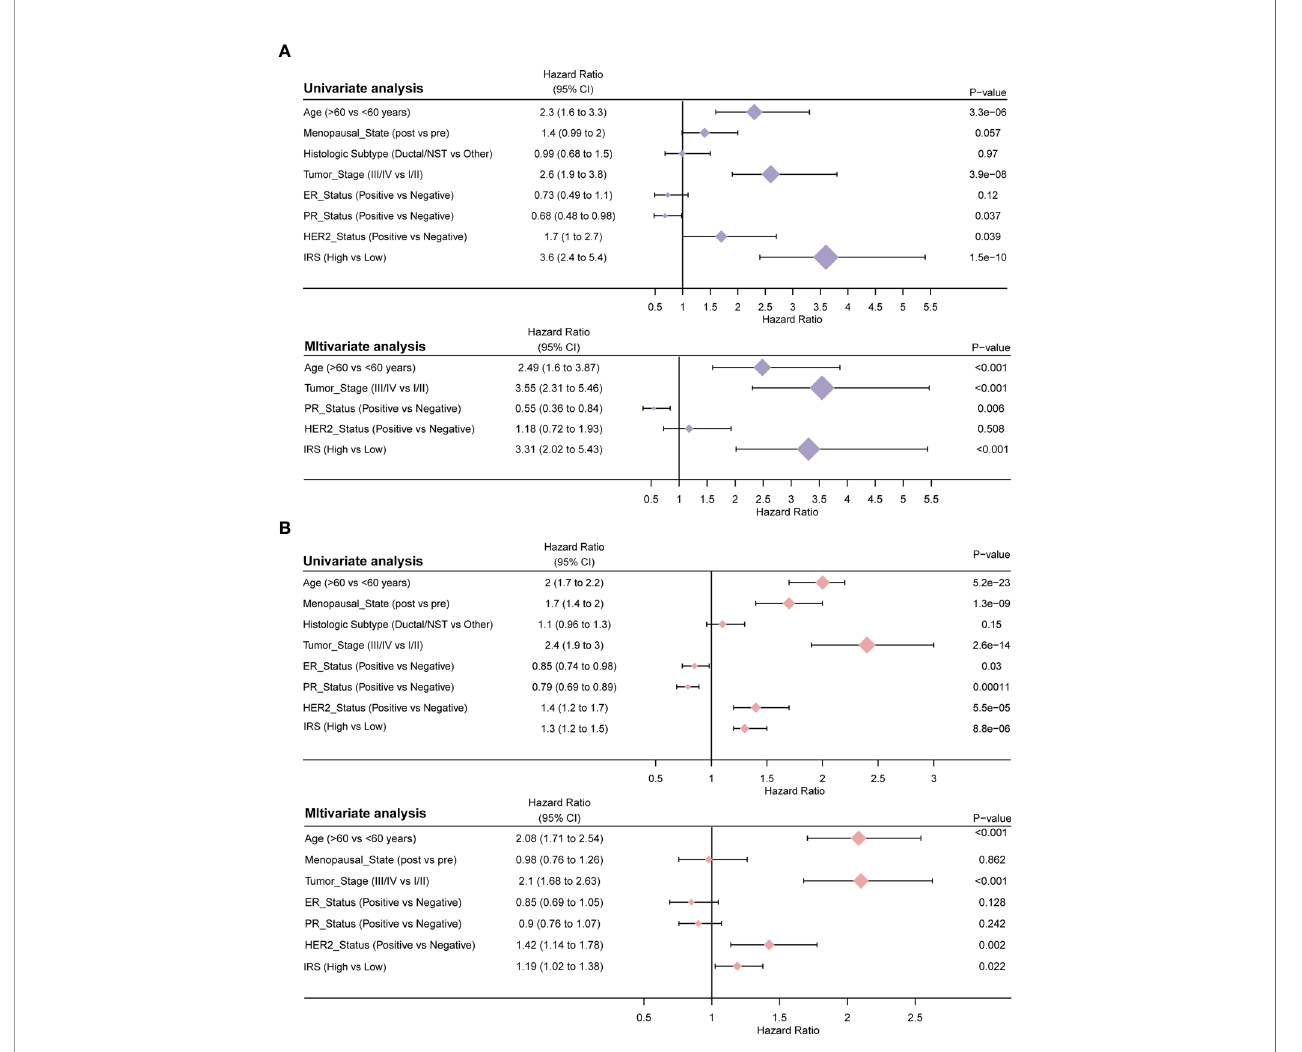
FIGURE 6 | Results of the clinicopathological feature univariate and multivariate Cox regression analyses of OS in the TCGA training cohort (A) and the METABRIC validation cohort (B)